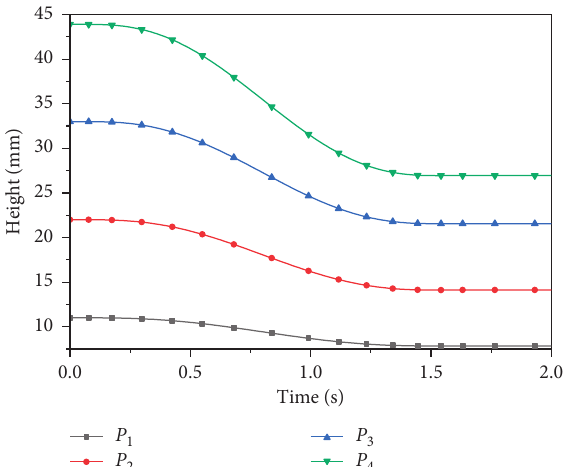
Figure 12: Time evolution of each coil endpoint height of the spring designed by TR algorithm in the compression